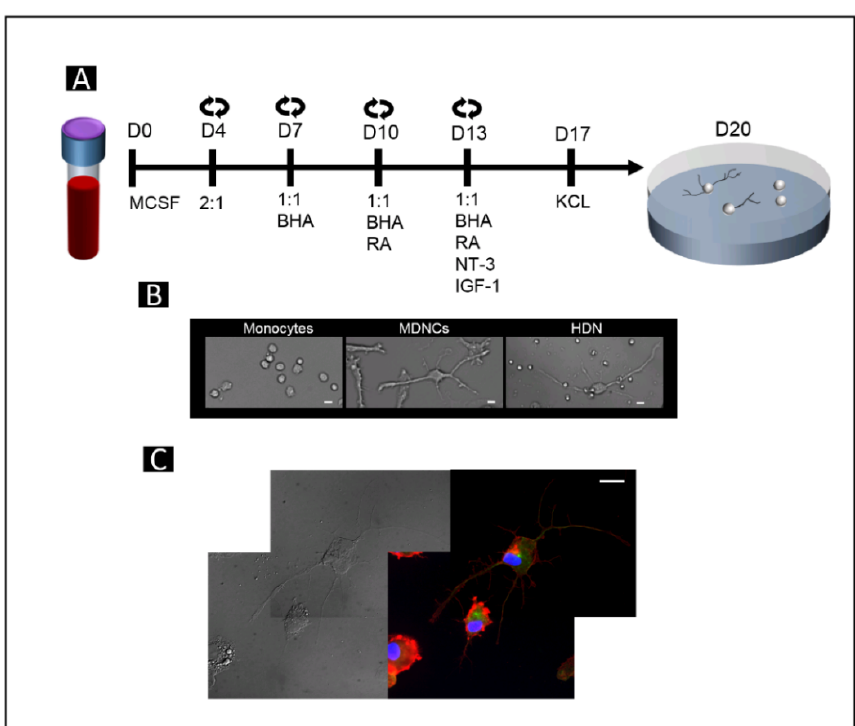
Figure 1. Transdifferentiation of human circulating monocytes into neuronal-like cells. ( A ) Schematic representation of our 20-day protocol for transdifferentiating human circulating monocytes into neuronal-like cells, starting from day zero (D0) with a blood sample and ending on D20 with neuronal-like cells. Circled arrows represent days on which media were changed. Cell cultured media were replaced with new DMEM, together with PBMCs conditioned media, at a rate of either 2:1 or 1:1 (DMEM/PBMCs), depending on the day of culture, as depicted in the diagram. DMEM was supplemented with different chemicals and growth factors depending on the day of culture, as depicted in the diagram. Exact concentrations are described in the Materials and Methods section. ( B ) Light microscopy photographs of monocytes, right after isolation from PBMCs, monocyte-derived-neuronal-like cells (MDNCs) and human developing neurons (HDNs) in culture for 5 days (20 × original magnification). ( C ) Light microscopy photographs of MDNCs in parallel with immunostainings showing tubulin in green and actin in red. The cells’ nuclei were stained with DAPI in blue (60 × original magnification). Scale bar = 20 µ